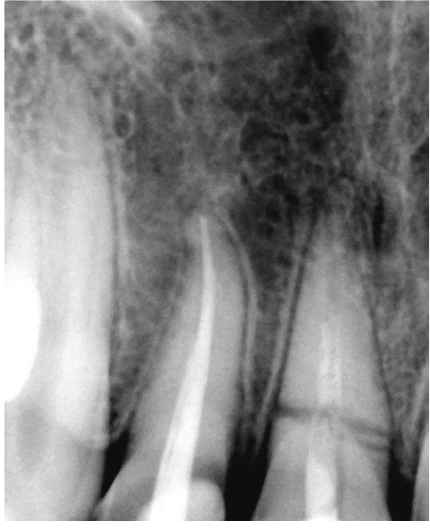
Figure 4: Working length 12.